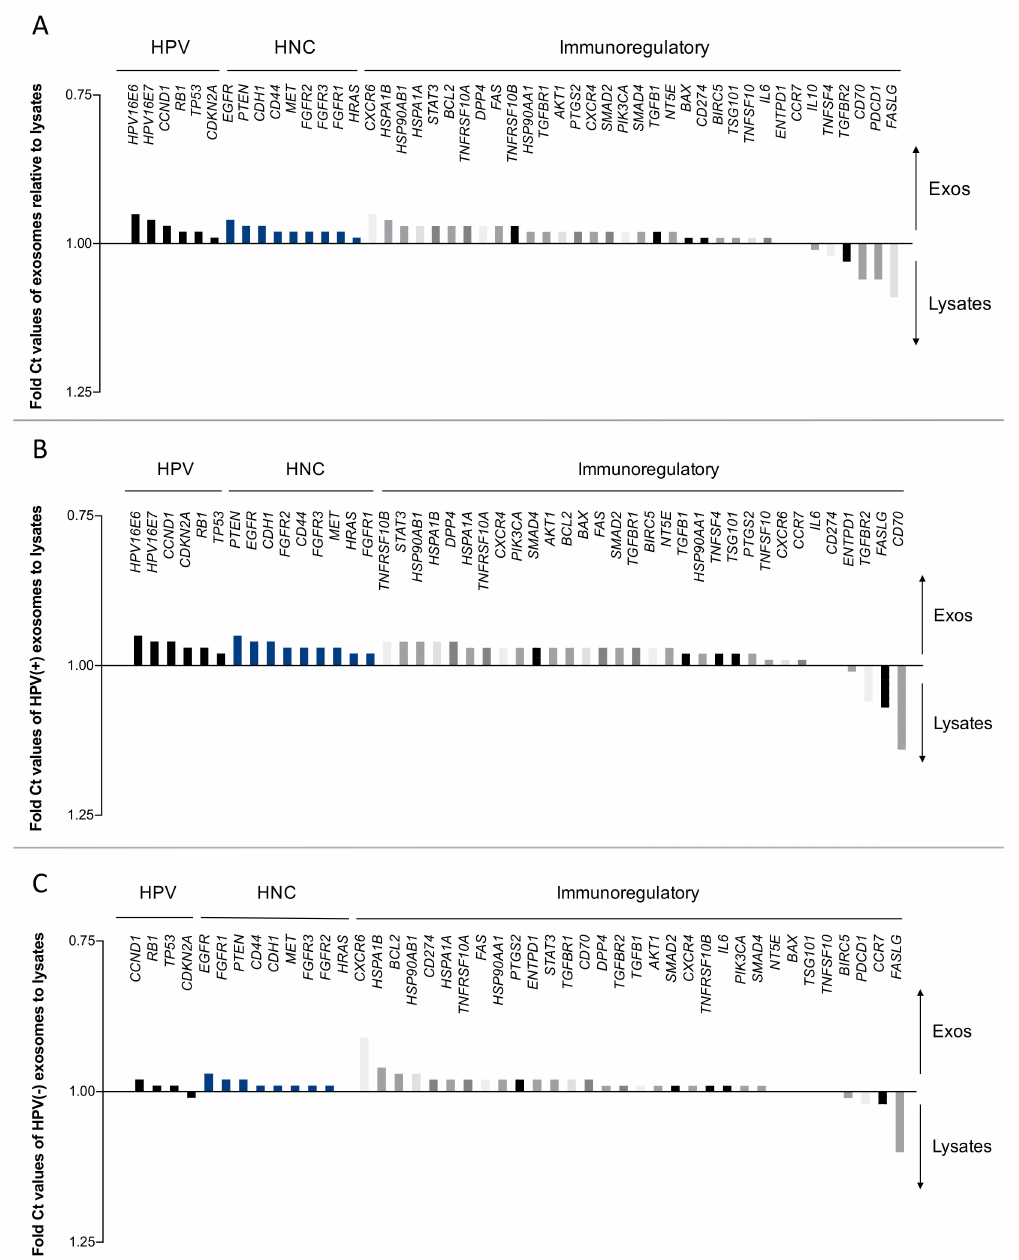
Figure 2. Relative mRNA expression depending on the localization in exosomes or cell lysates. Means of absolute Ct values from three replicates were compared for mRNA expression in exosomes in relation to mRNA expression in cell lysates ( A ). In the sub-analysis, relative mRNA expression was compared for HPV( + ) ( B ) and HPV( − ) samples ( C ). The data are presented as waterfall plots to visualize the degree of overexpression, equal expression or underexpression of mRNA in exosomes relative to the cell lysates for each mRNA species. The data are presented in fold Ct values on an inverted scale to reflect the fact that lower Ct values correspond with higher mRNA